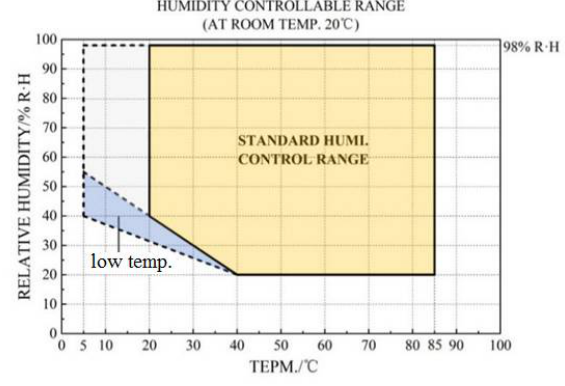
Figure 4. The range of temperature and